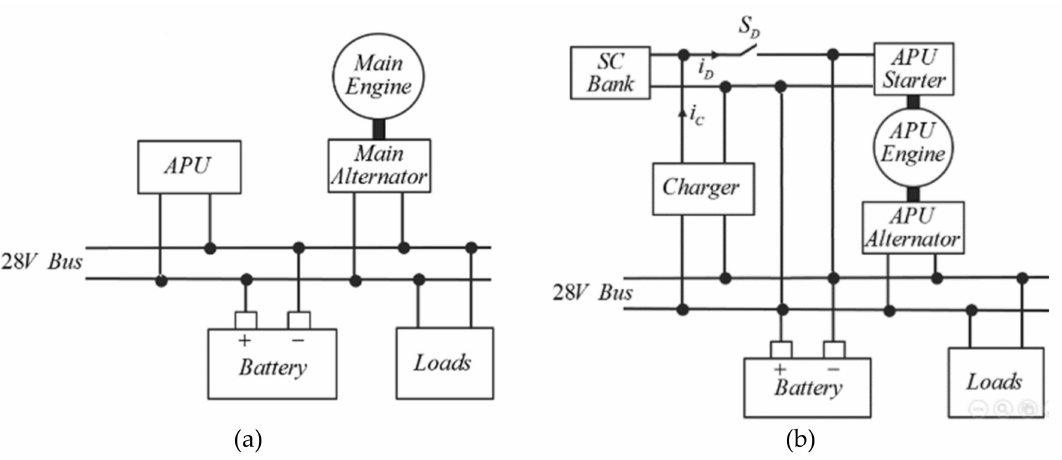
Figure 2. Block diagram representation of auxiliary power unit (APU)-assisted heavy vehicle electrical system. ( a ) General arrangement and ( b ) with a supercapacitor-based emergency starter (SCS) starting